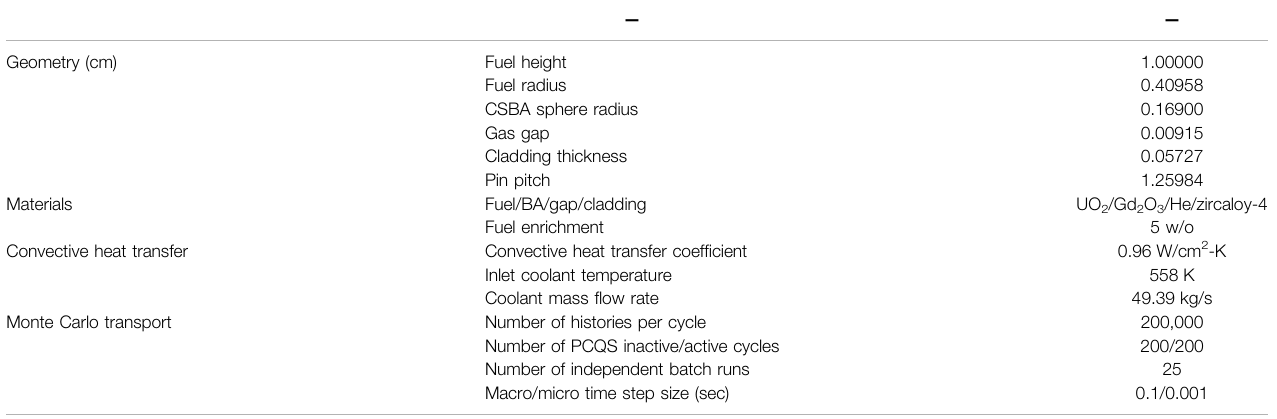
TABLE 1 | CSBA fuel pellet analysis condition.